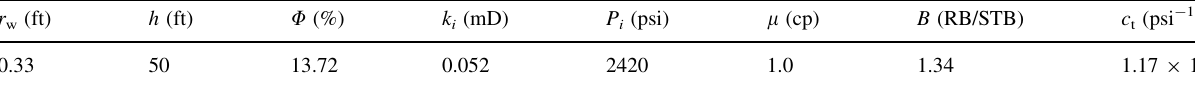
Table 2 Reservoir and fluid properties used for simulation